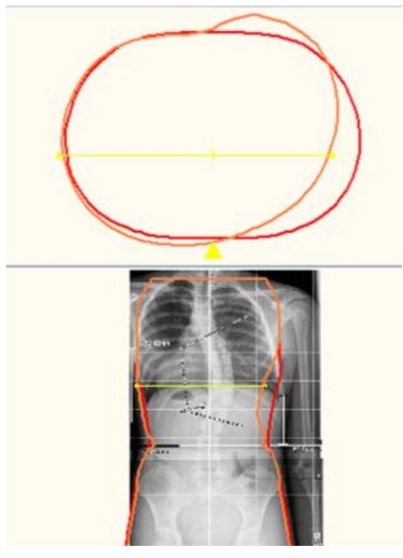
Figure 6. Transverse view through apex.